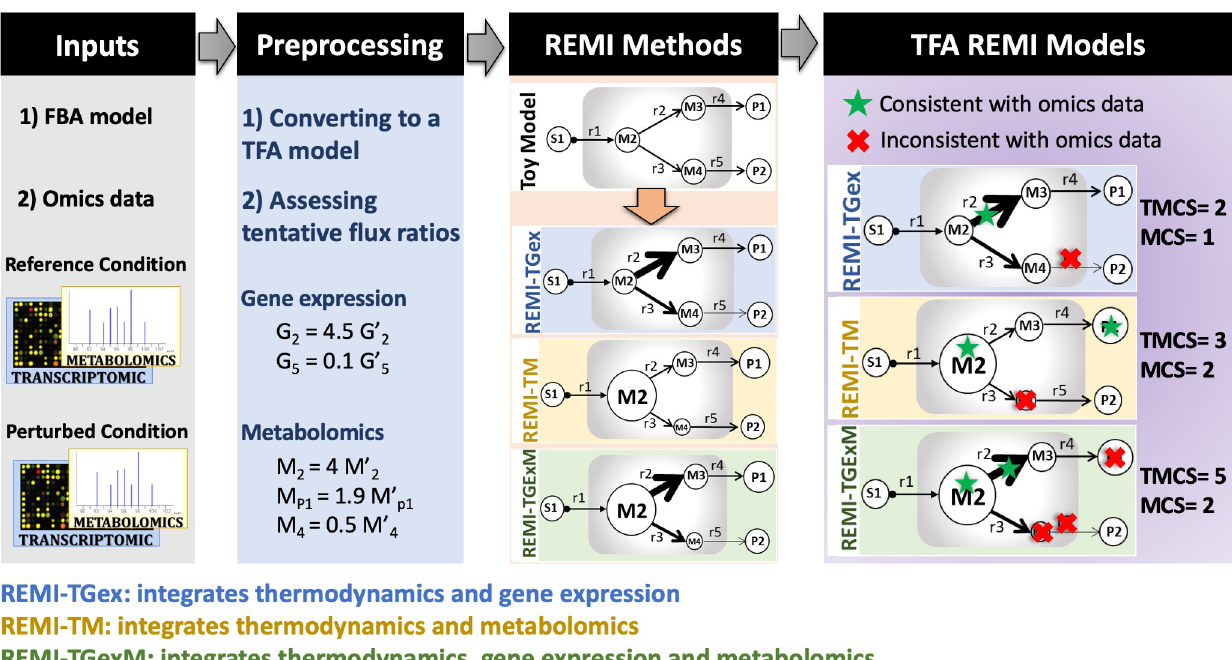
Fig 1. The REMI workflow requires two inputs: a genome-scale flux balance analysis (FBA) model and sets of gene-expression and/or metabolomic data. In the pre-processing step, the FBA model is converted into a thermodynamic-based flux analysis (TFA) formulation, and the relative flux ratios are further assessed based on the omics data. Also based on the omics data provided, REMI translates to the REMI-TGex, REMI-TM, and REMI-TGexM methods (third block). Examples of gene-expression and metabolomic data (second block) together with a toy mode (third block) are used to illustrate the applicability of the REMI methods. The theoretical maximum consistency score (TMCS) is the number of available omics data (for metabolites, genes (reactions), or both) and the maximum consistency score (MCS) is the number of those constraints that are consistent with fluxes and could be integrated into REMI models. The MCS is always equal to or smaller than the